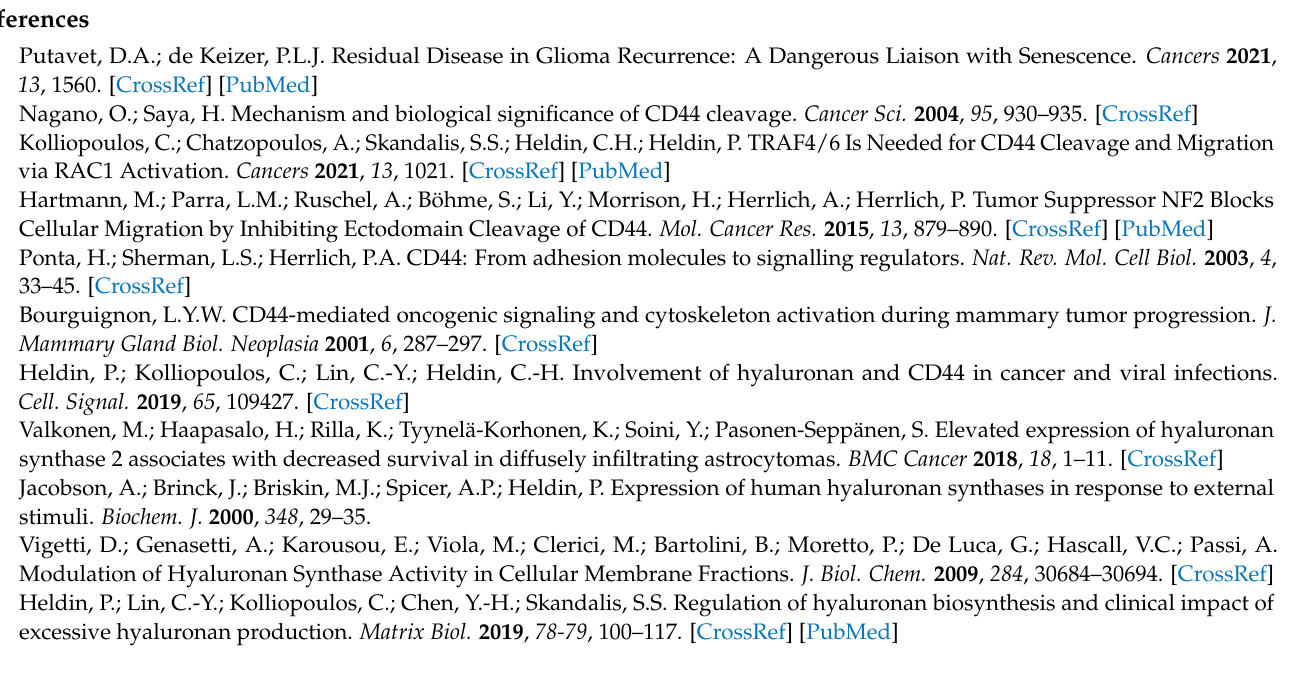
cells, Figure S5. Perturbation of ERK1/2 MAPK and CREB signaling pathways in CD44 KO cells or U251MG cells stably transfected with shHAS2, Figure S6. Uncropped Western Blot images for Figure 1a, Figure S7. Uncropped Western Blot images for Figure 1e, Figure S8. Uncropped Western Blot images for Figure 1g, Figure S9. Uncropped Western Blot images for Figure 3c, Figure S10. Uncropped Western Blot images for Figure S3, Figure S11. Uncropped Western Blot images for Figure S6, Table S1. Specific gene signatures (hallmarks) CD44 KO vs Parental and DAPT vs Parental, Table S2. Complete Filtered_DEGs_and_Common_DEGs_All_samples, Table S3. Complete